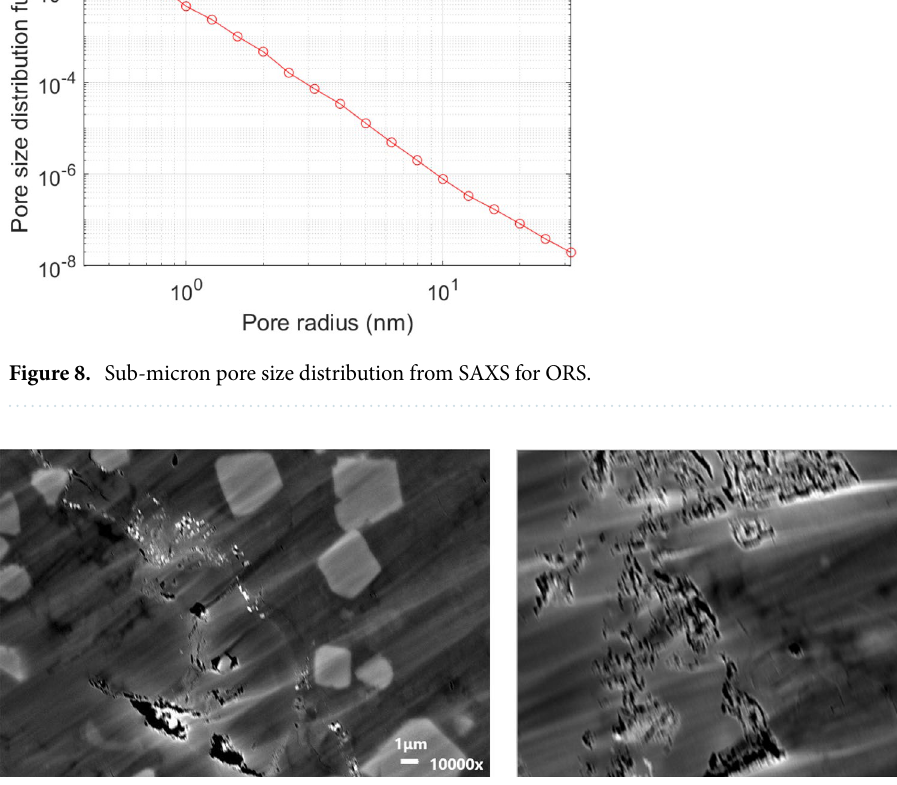
Figure 9. FIB–SEM images of shale sample showing the sub-micron